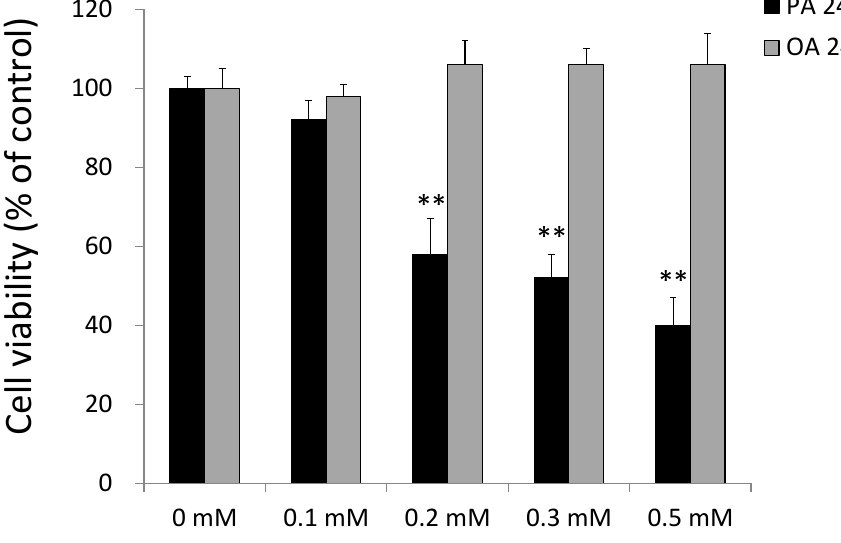
Figure 2. The effects of palmitic acid (PA) and oleic acid (OA) on cell viability of SH-SY5Y cells. SH-SY5Y cells were treated with the vehicle control (0 mM), 0.2~0.5 mM PA, or 0.2~0.5 mM OA for 24 and 48 h. After treatment, cell viability was measured by